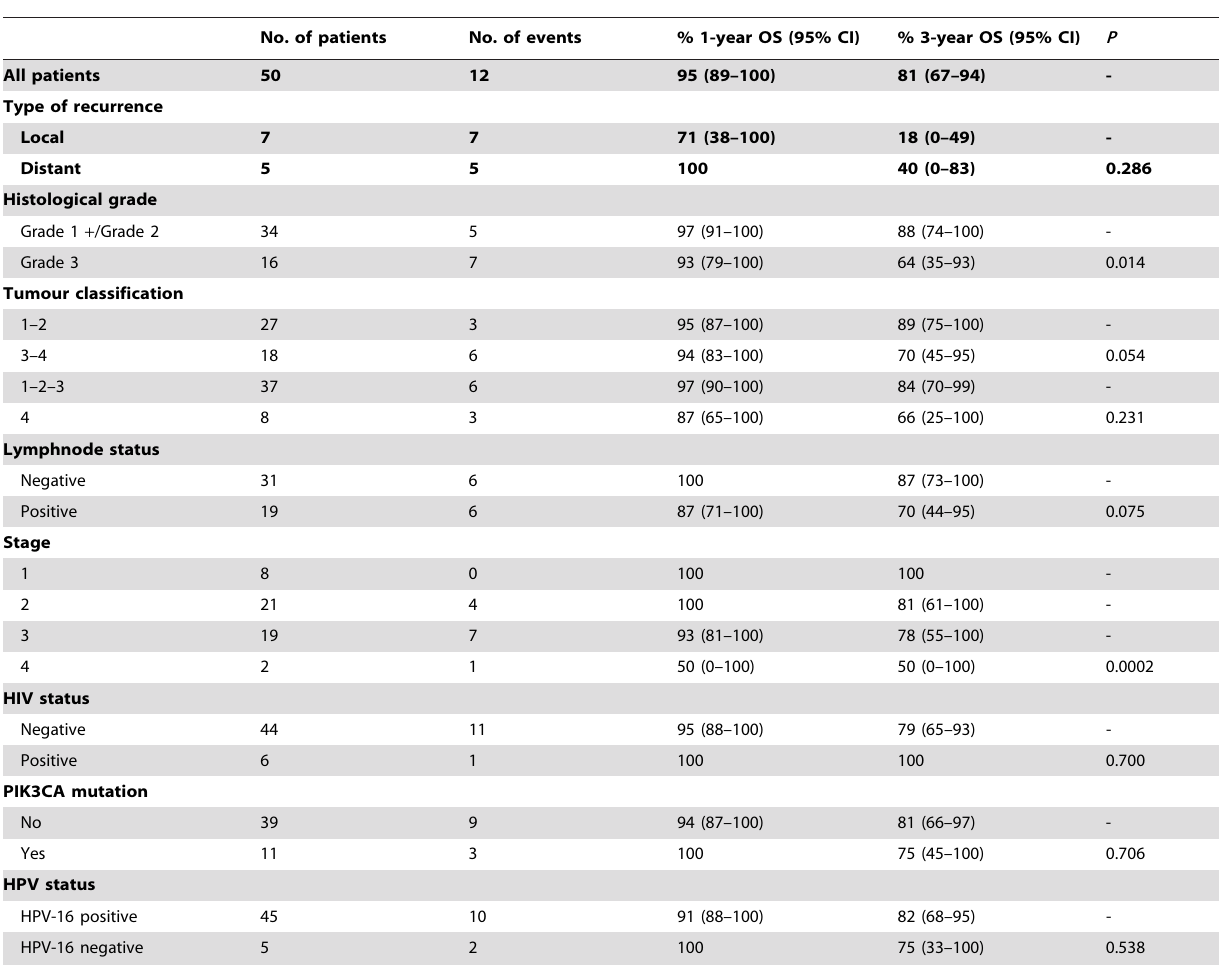
Table 4. Overall survival in relation to clinical-pathological characteristics of